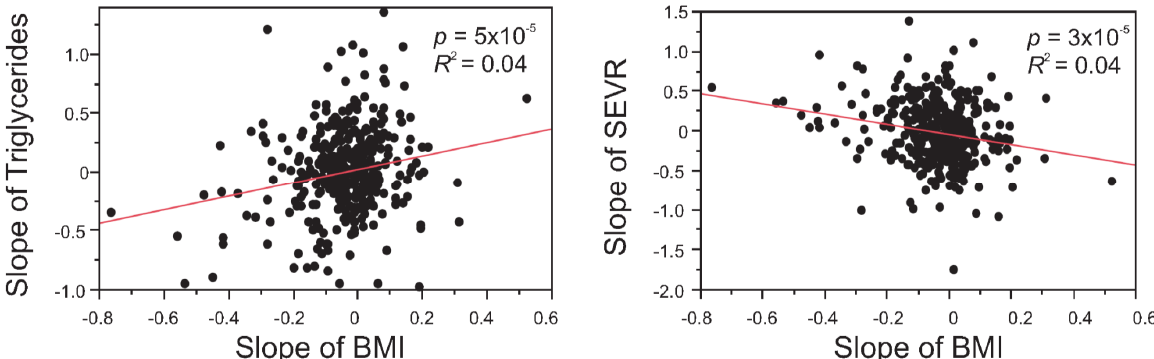
Figure 4. Correlation between the slopes of risk factors. ( A ) Significant positive correlation between change in BMI and change in Triglycerides, largely driven by individuals whose BMI drops (negative slope) also showing reduced triglycerides; ( B ) Significant negative correlation between slope of sub-endocardial vascular risk ratio (SEVR) and slope of BMI, again indicating improved cardiovascular health in individuals whose BMI decreases overall. p -Values for Pearson correlations are indicated on the figure,